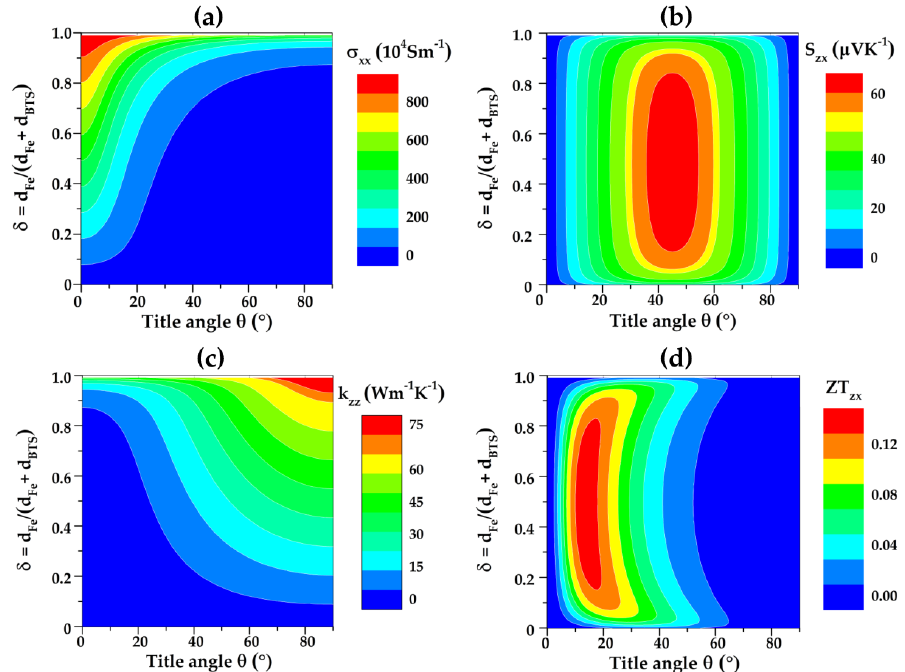
Figure 3. Thickness ratio ( δ ) and tilted angle ( θ ) dependences of ( a ) electrical conductivity σ xx ; ( b ) transverse Seebeck coefficient S zx ; ( c ) thermal conductivity κ zz ; and ( d ) transverse figure of merit ZT zx of Fe/BTS ATMTD.